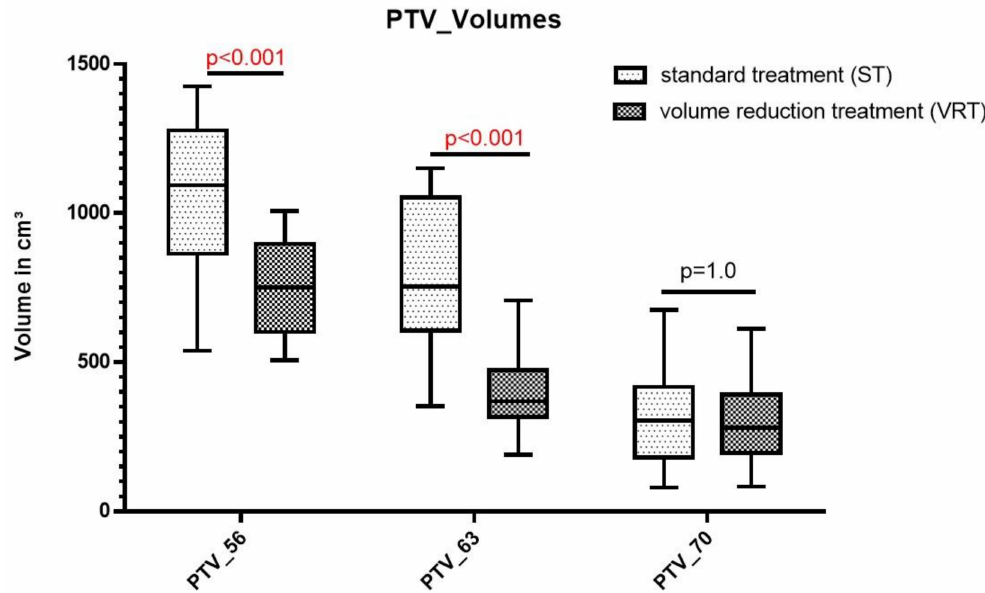
Figure 2. Box-Whisker-Plot comparing the different PTV_Volumes. While significant dose reduction is achieved for PTV_56 and PTV_63 applying the simulated volume reduction treatment, no significant differences were observed for PTV_70 between the standard treatment and the volume reduced